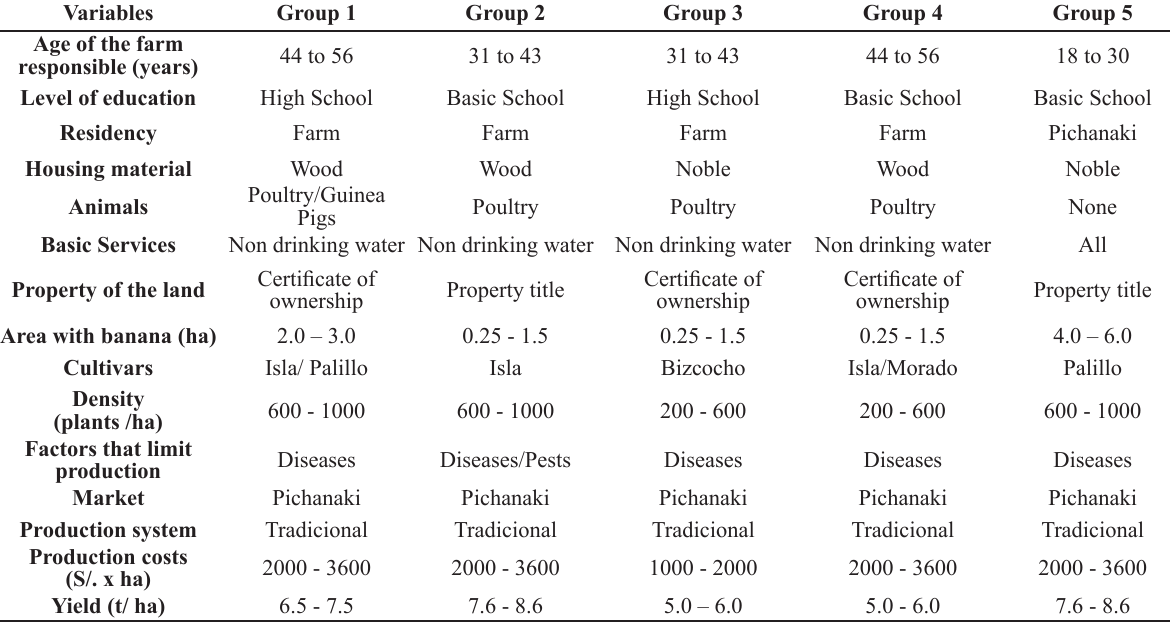
Table 1. Main characteristics of the groups of banana farms in the Cuyani microbasin, district of Pichanaki, province of Chanchamayo,